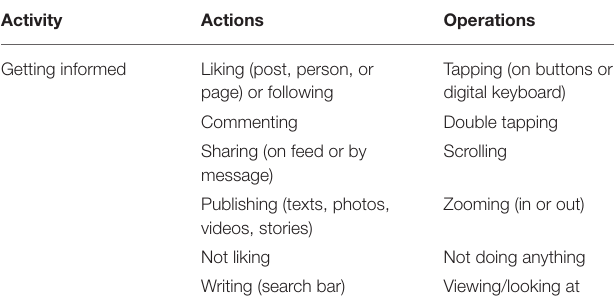
TABLE 1 | The hierarchical model of getting informed on social media.